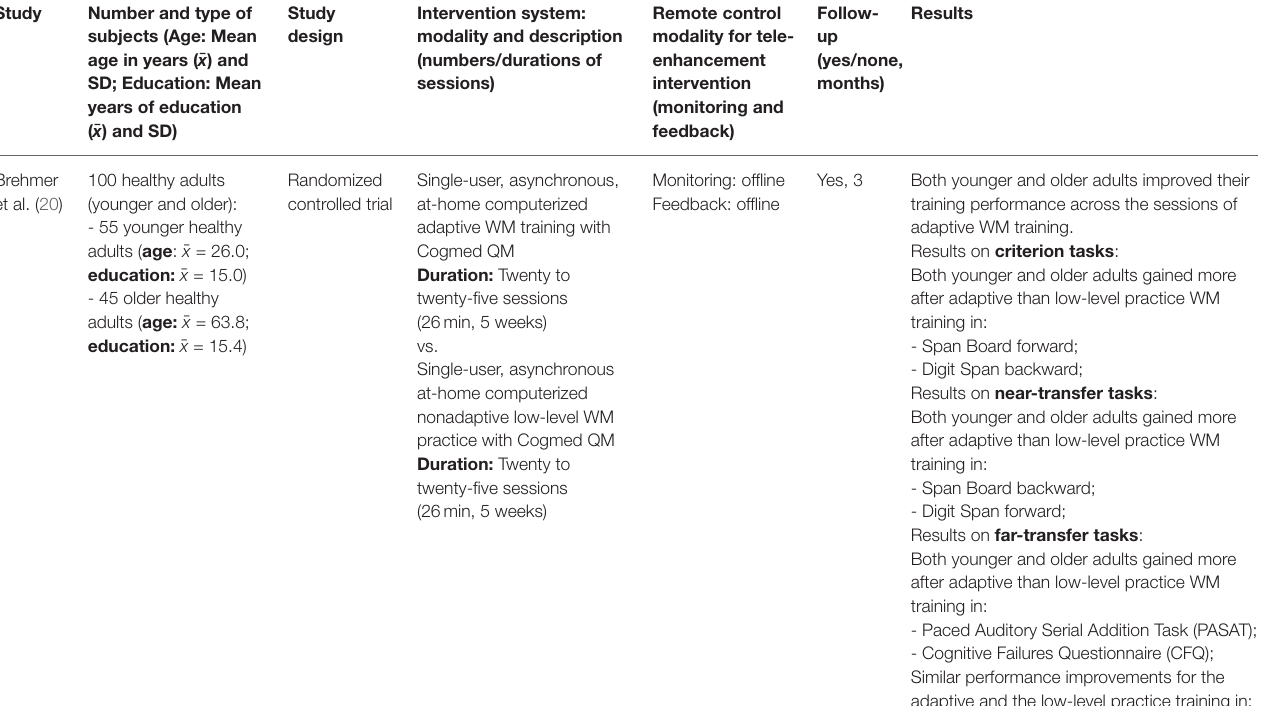
TABLE 1 | Studies that have assessed the effects of cognitive tele-enhancement interventions on cognitive functions in healthy older adults.